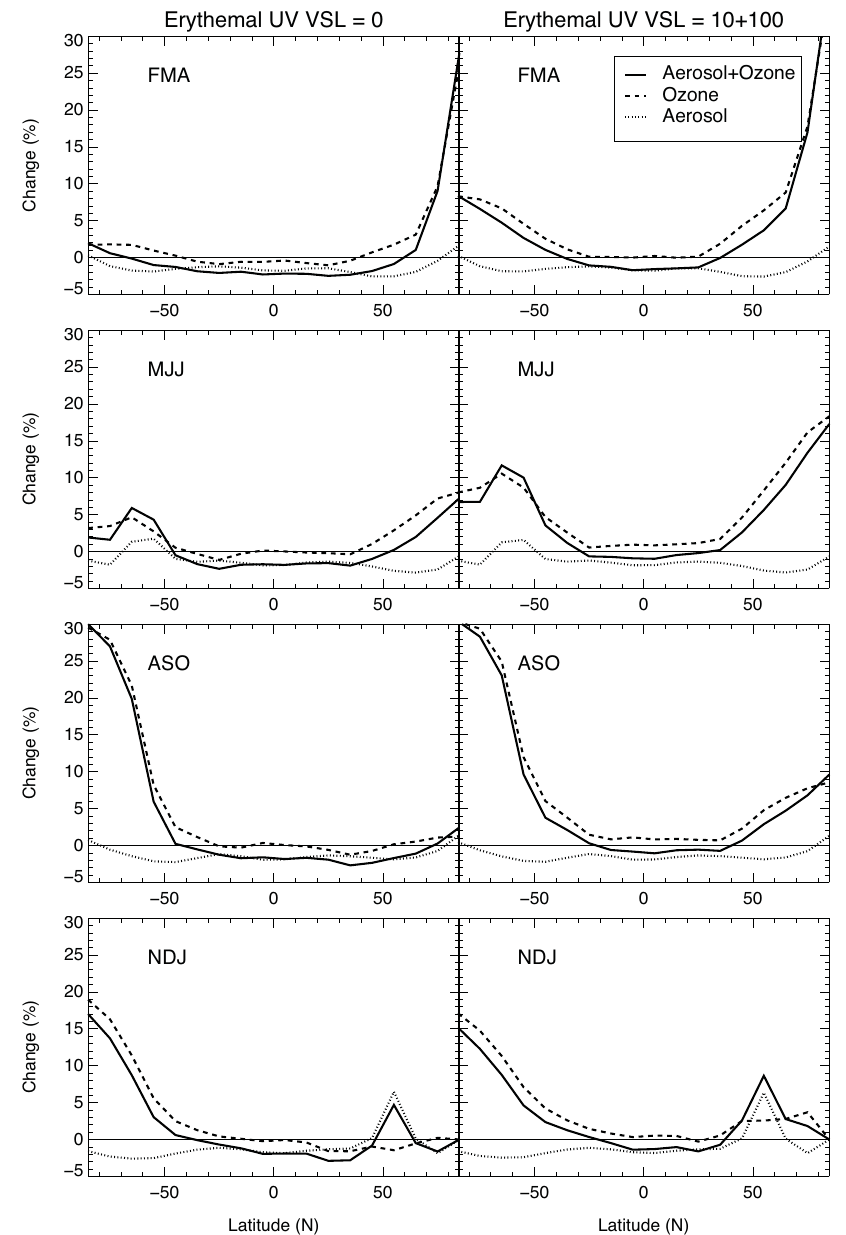
Fig. 4. Changes in UV ERY as a result of geo-engineering, assuming volcanic-sized aerosols for the year 2040, based on changes of column ozone only (dashed lines), changes due to the enhanced volcanic-sized aerosol scattering only (dotted lines), and, consideration of both column ozone changes and enhanced aerosol scattering (solid). Results are shown for four seasons, noontime conditions averaged over 10 degrees latitude bands. We consider simulations with two different amounts of VSL halogen species in the stratosphere (VSL = 0: left column, Br VSL y = 10ppt and Cl VSL y = 100ppt: right